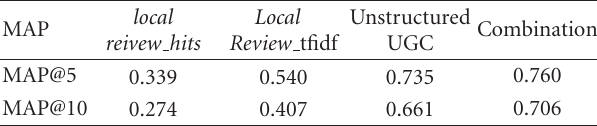
Table 3: Mean average precision of di ff erent